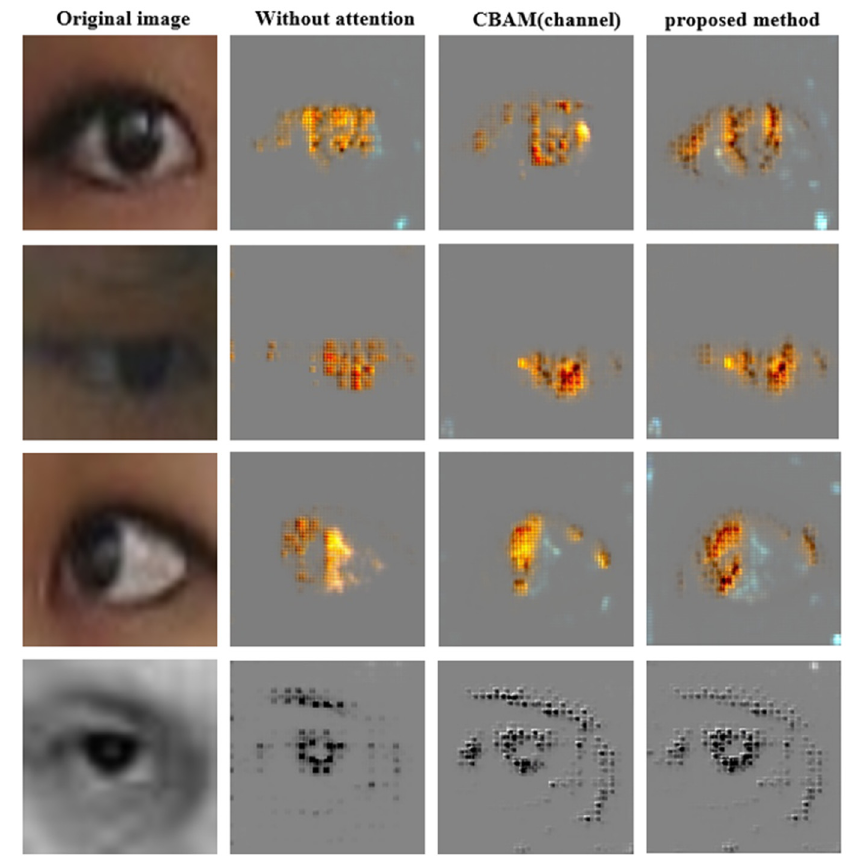
Figure 7. Using Grad-CAM to visualize the details learned by the network.